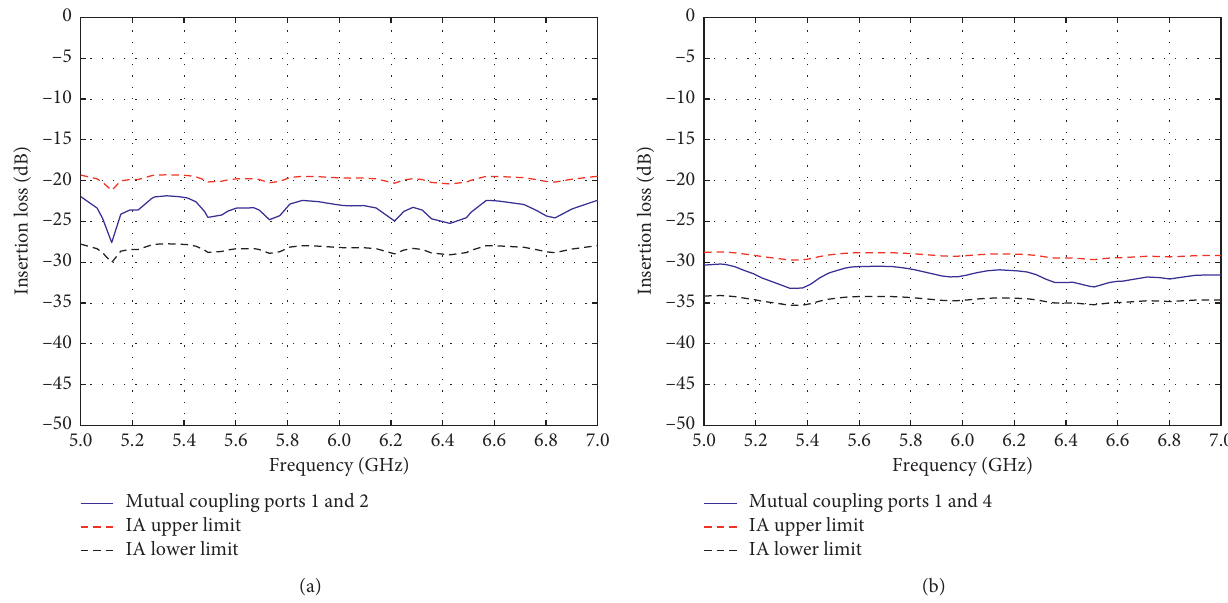
Figure 12: C-band Rotman lens: coupling factor vs. frequency (a) between ports P1 and P2 and (b) between ports P1 and